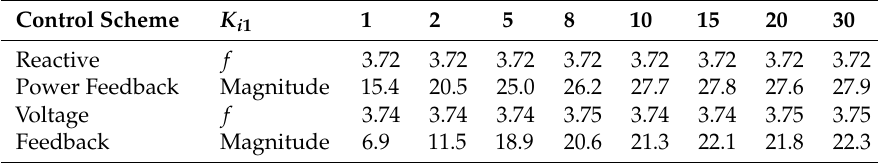
Table 2. The oscillation frequency and its magnitude with the ranging of K i 1